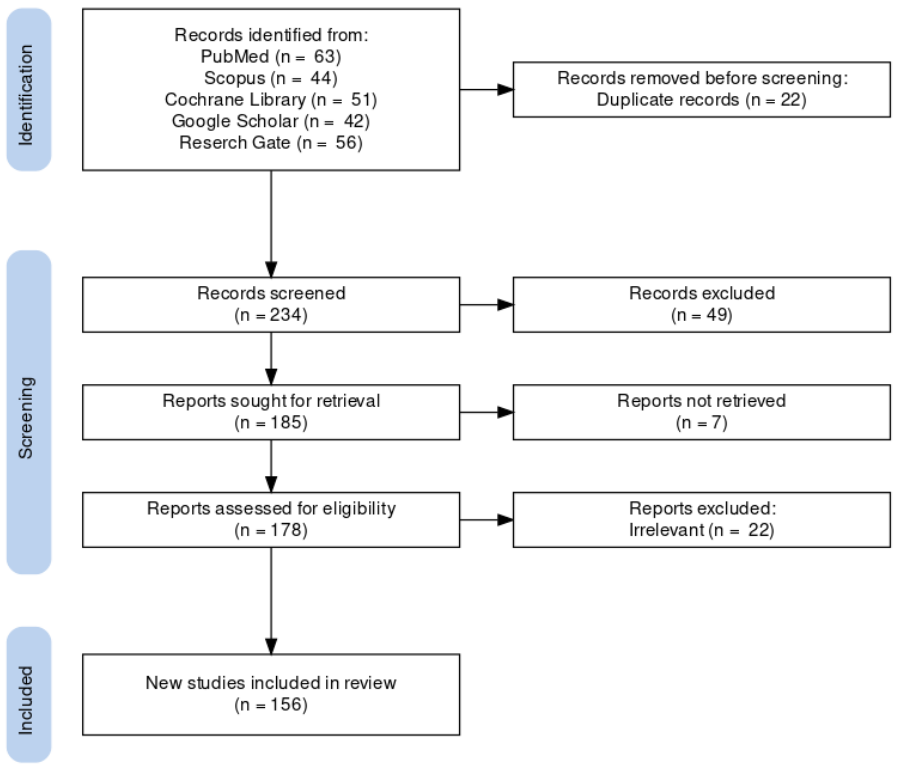
Figure 1. The PRISMA flow diagram.